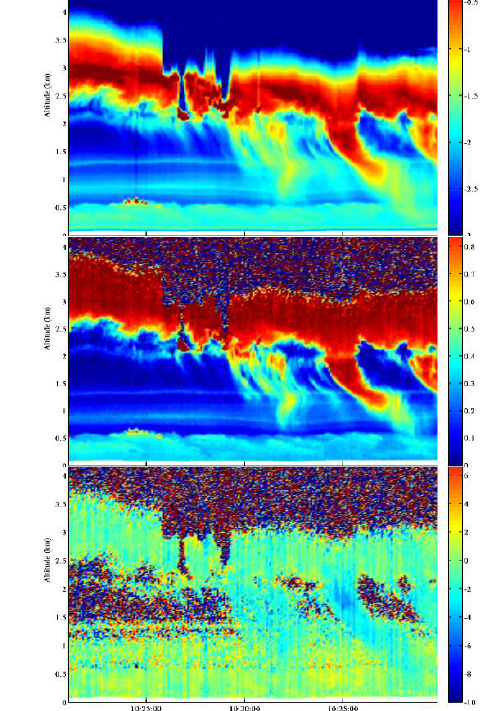
Fig. 1 : (top plot) Time-altitude cross-section of the logarithm of the 1064 nm range-corrected signals showing precipitating altostratus cloud above the 500m high boundary layer ; (middle plot) UV contrast M determined from MZI and (bottom plot) vertical air speed retrieved in the cloud and boundary layer. A 20 mn sequence of G/B measurements is shown for 11 May